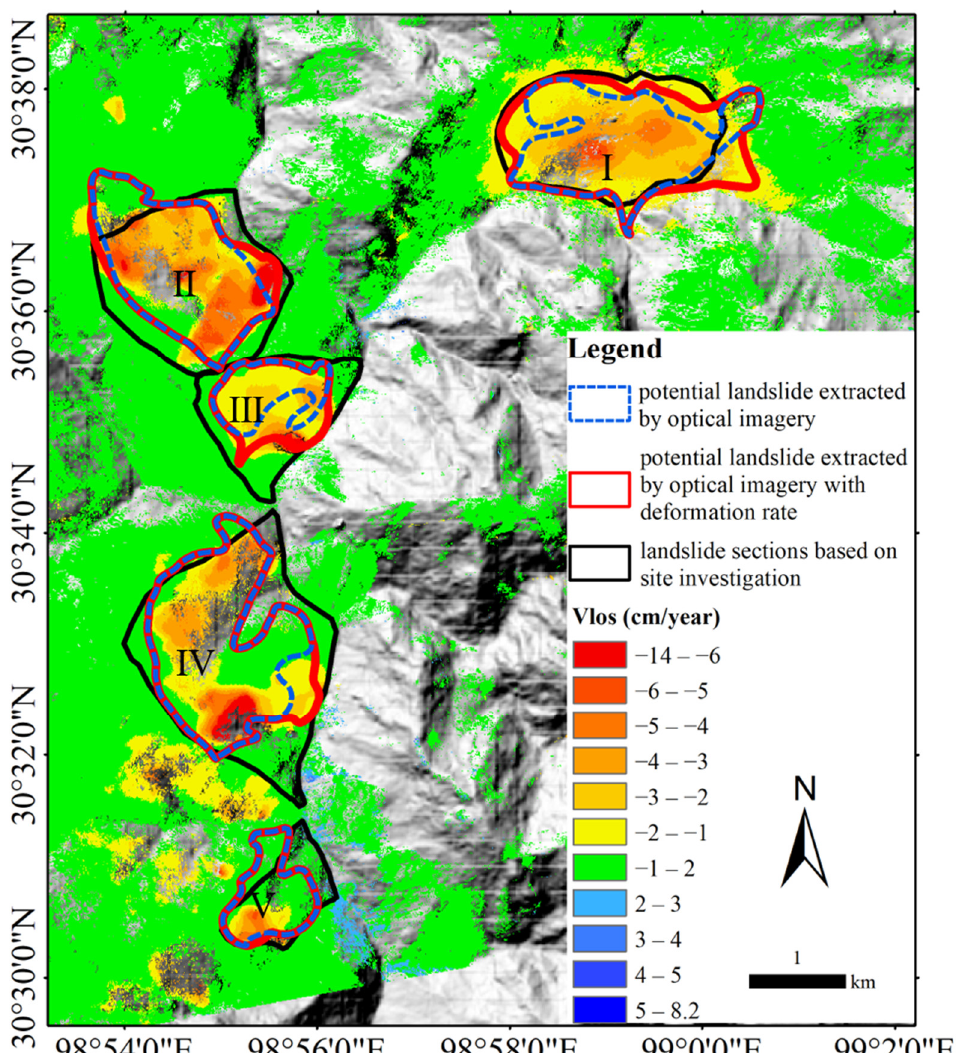
Figure 9. Potential landslide identification with the OBIA method by using a purely optical image (blue dash polygons), and by integrating the optical image with the InSAR—derived deformation map (red solid polygons).